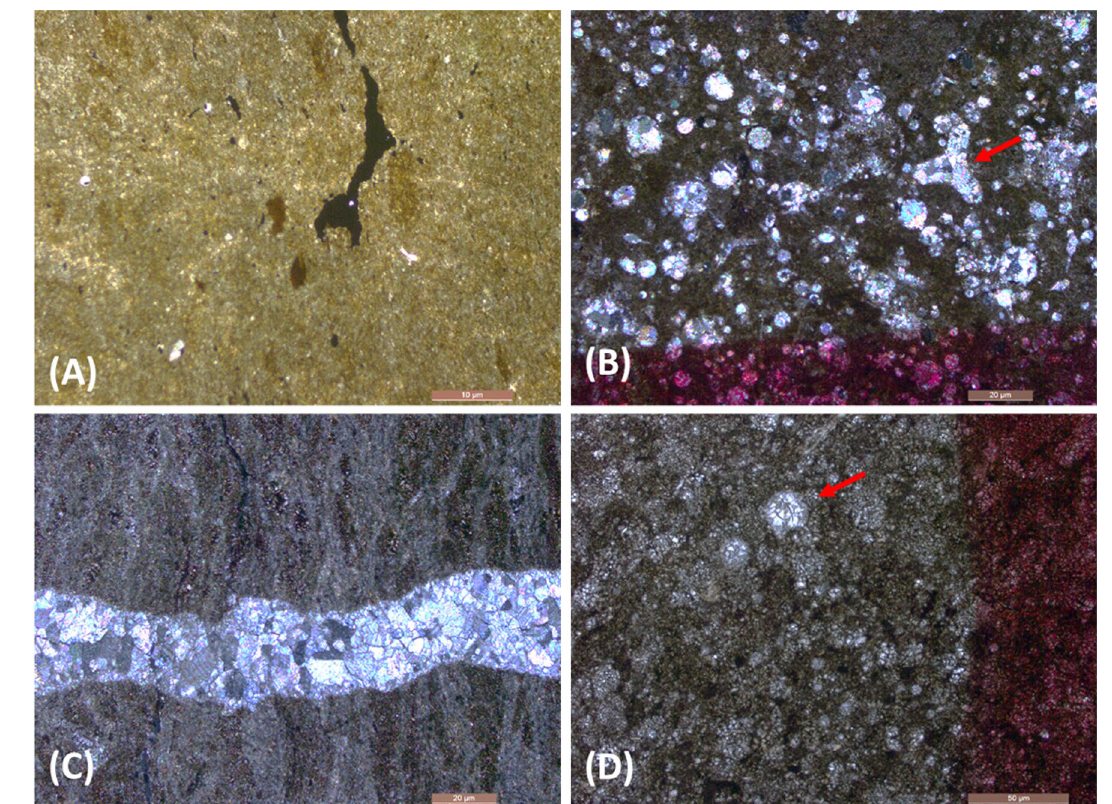
Fig. 7 a Micritic groundmass containing high percentage of organic matter, and neomorphosed to microsparite. Vuggy porosity is t filled with organic matter, Br-64, X.N., b Granular Cement (arrow) in a mold of radiolaria, creating moldic porosity within the sponge Spic- ules, Br-43, X.N., c Drusy cement (arrow), within articulated ostra-